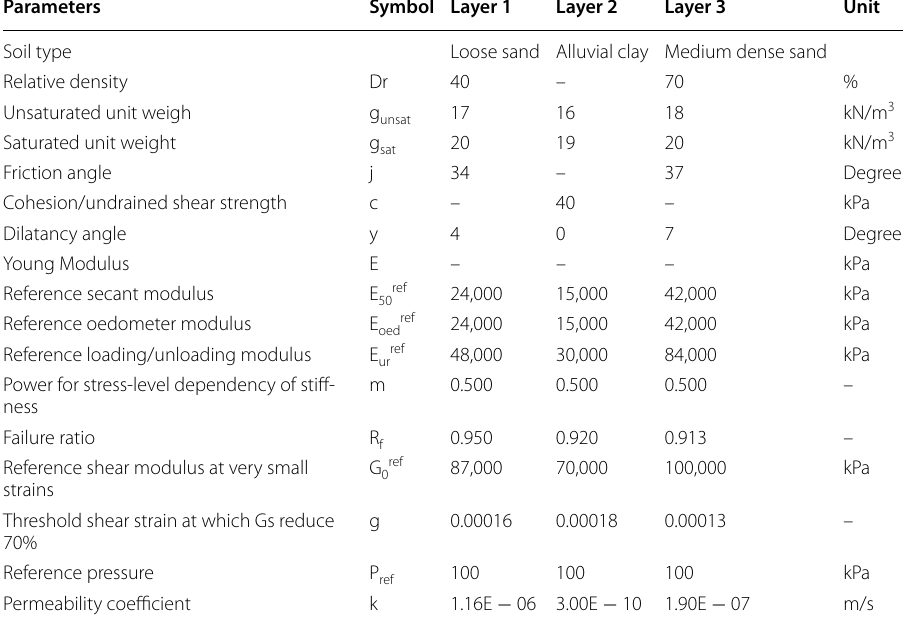
Table 3 The HS‑small model soil properties [15, 24] Parameters Soil type